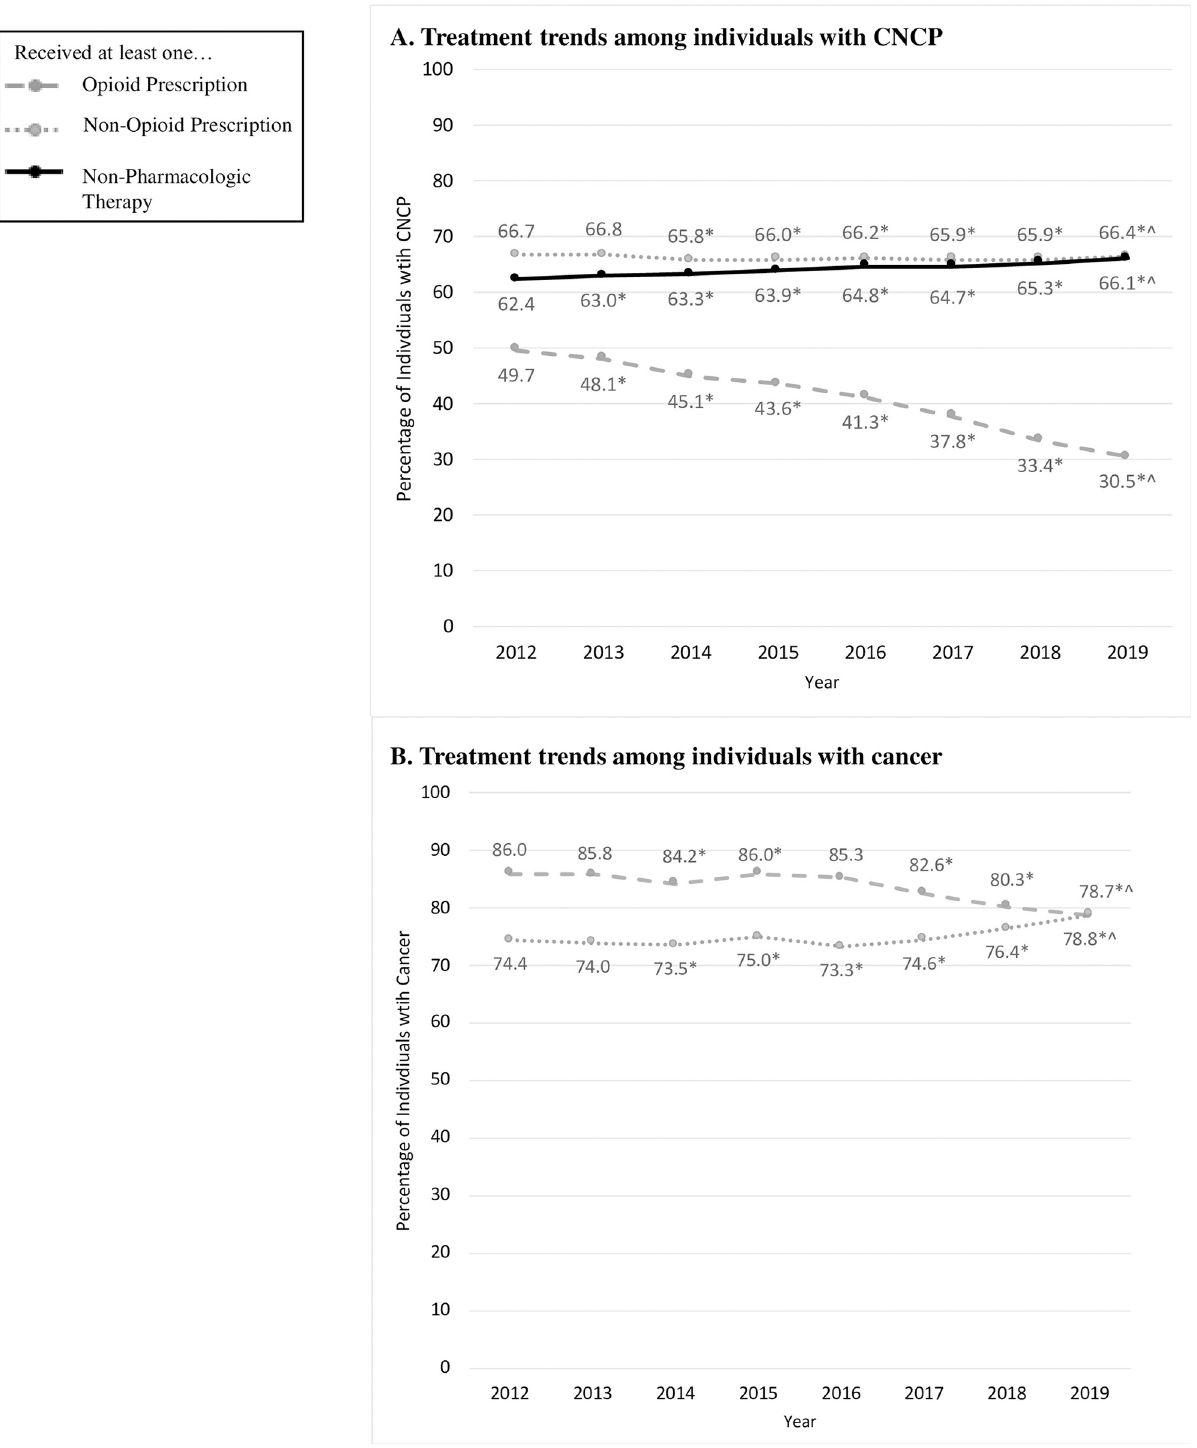
Fig 1. Adjusted opioid and non-opioid treatments among individuals with chronic non-cancer pain (CNCP) or cancer, 2012–2019.